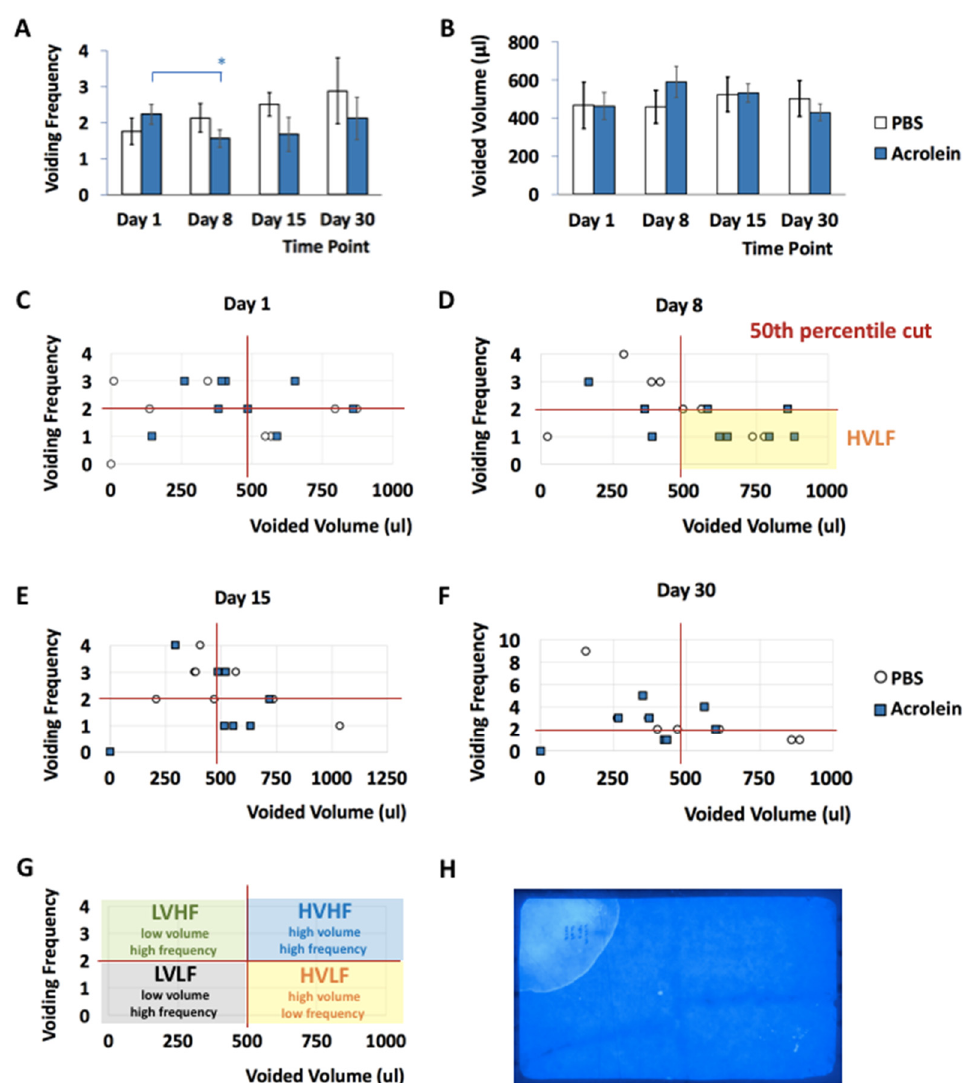
Figure 3. Micturition patterns in PBS and acrolein mice evaluated by filter paper assay (FPA). ( A ) The number of urine spots ( ≥ 1.0 cm) in PBS and acrolein mice. * p ≤ 0.05 to respective acrolein group values on day 1 pi. ( B ) Analysis of voided volume per void ( µ L) of the same groups of animals. 2D plot of the voiding frequency and volume per void ( µ L) for each PBS and acrolein mouse at days 1 ( C ), 8 ( D ), 15 ( E ) and 30 ( F ) having a 50th percentile cut-off point. ( G ) Exemplary plot of voiding frequency and voided volume per void (µL) with the domain of low volume high frequency (LVHF), high volume high frequency (HVHF), low volume high frequency (LVHF) and high volume low frequency (HVLF) defined by the presented percentile cut of frequency and volume. ( H ) Exemplary image of a filter paper scanned under UV light.